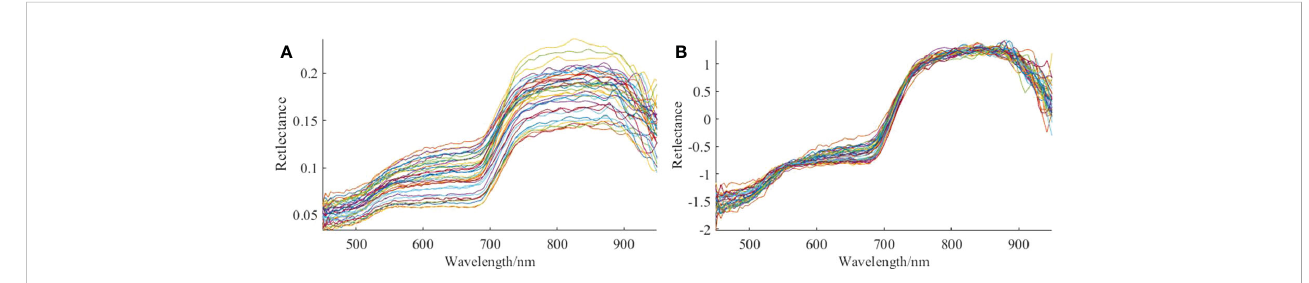
FIGURE 5 Hyperspectral preprocessing results. (A) Average re fl ectance spectra of canopy (B) . Spectrum diagram of SNV algorithm preprocessing.